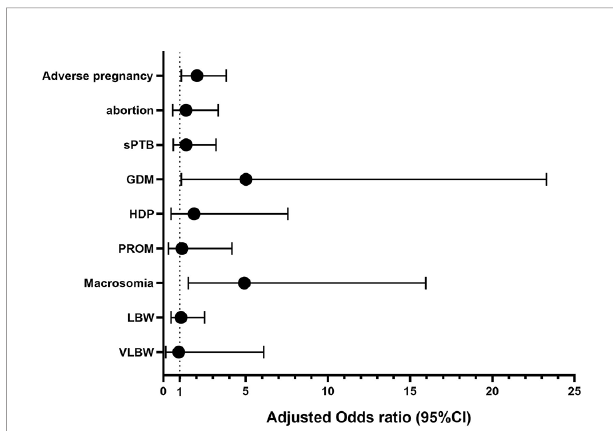
FIGURE 3 | Adjusted OR (95%CI) of Amenorrhea and maternal and perinatal outcomes. Adverse pregnancy adjusted by BMI and hCG injection day endometrial thickness; GDM adjusted by Age and BMI; Abortion adjusted by LH/FSH and AMH; Macrosomia adjusted by BMI, AFC, Starting dose of Gn, No. of oocytes retrieved and Multiples rate; sPTB adjusted by AFC and hCG injection day endometrial thickness; HDP adjusted by BMI, Starting dose of Gn, hCG injection day E2 and LH; PROM adjusted by hCG injection day endometrial thickness; LBW adjusted by AFC, Length of stimulation, Total dosage of Gn used, hCG injection day Endometrial thickness, No. of oocytes retrieved and Multiples rate; VLBW adjusted by Multiples